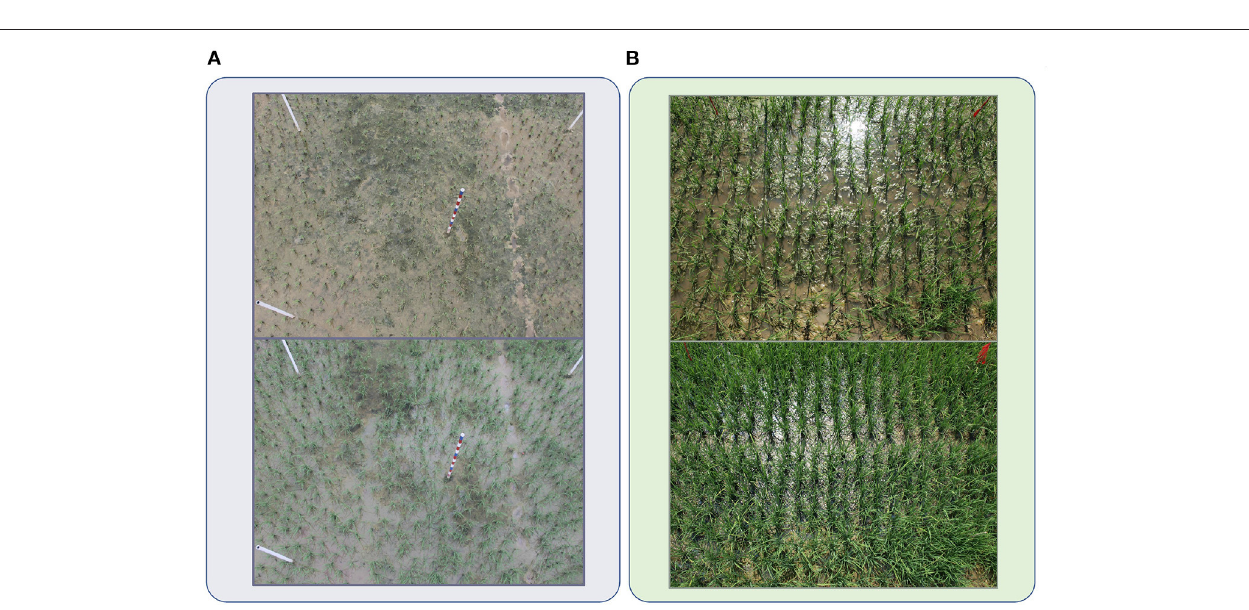
Frontiers in Plant Science |